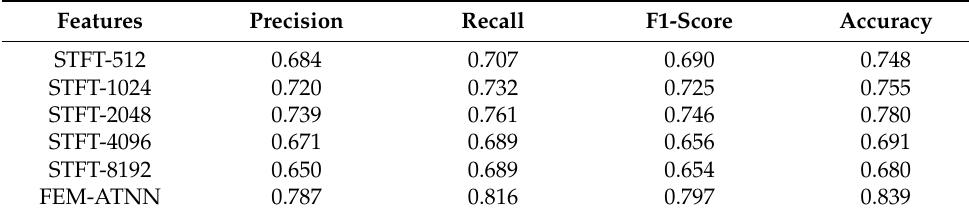
Table 5. Recognition results of the FEM-ATNN and the multi-resolution STFT.